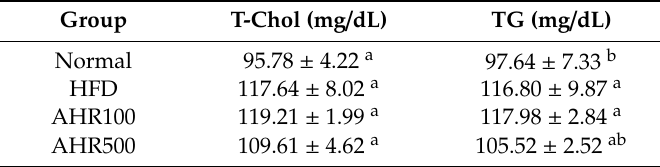
Table 6. E ff ect of AHR on serum lipid concentration in HFD-induced obese mice.